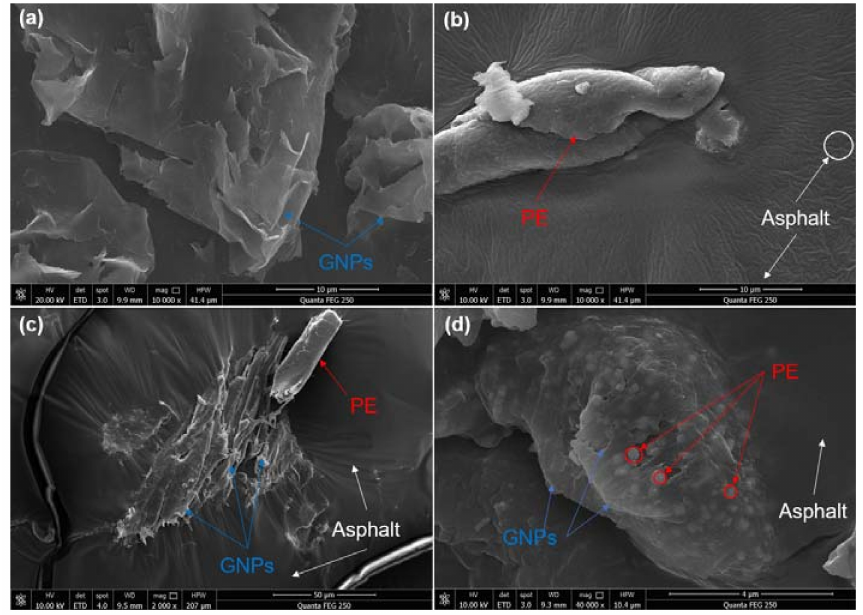
Figure 8. The SEM images of GNPs and various modified asphalt binders: ( a ) GNPs powder, ( b ) PE modified asphalt, ( c ) PE+GNPs modified asphalt, and ( d ) premixed PE/GNPs modified